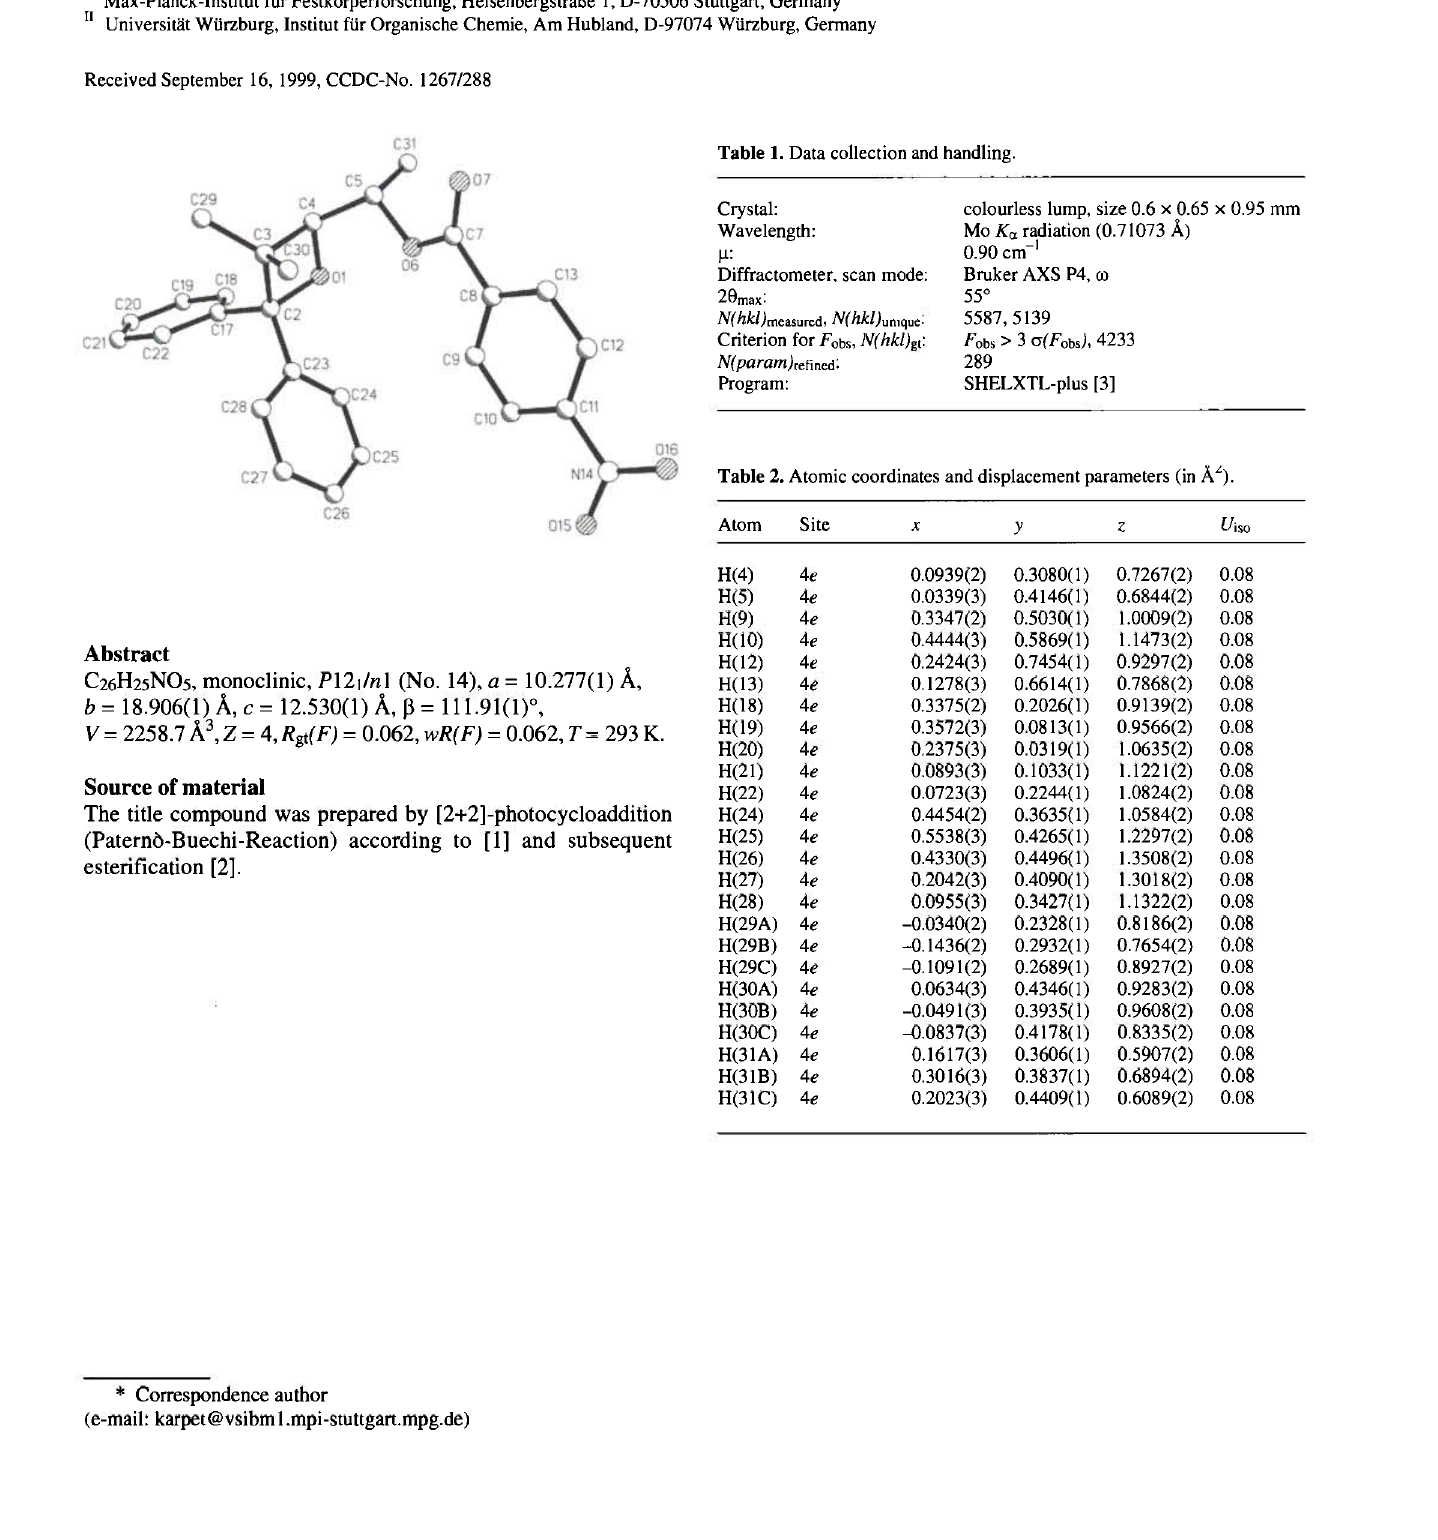
Table 2. Atomic coordinates and displacement parameters (in A